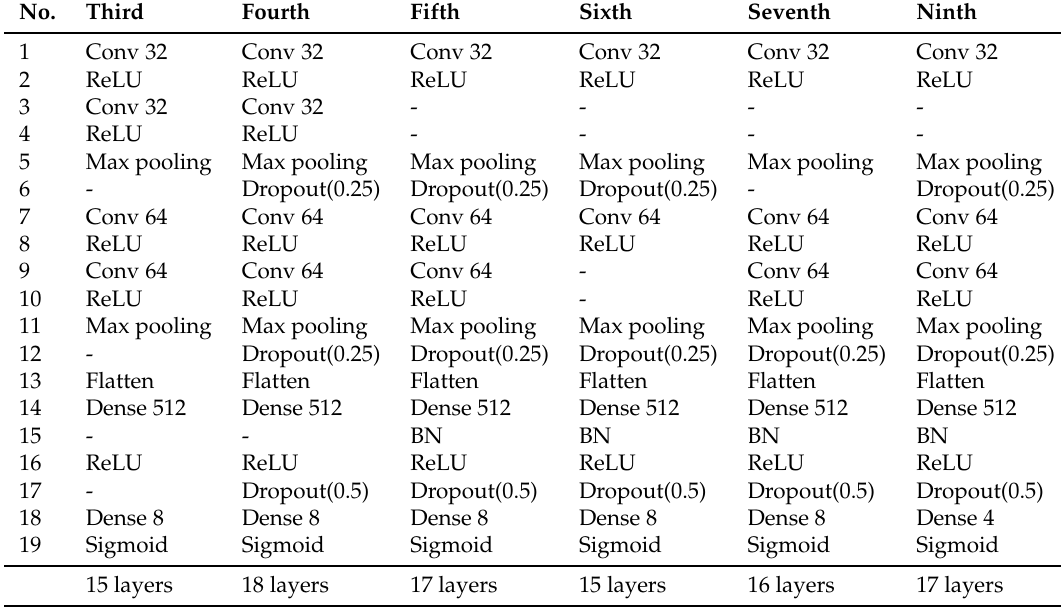
Table 3. Architecture of the third, fourth, fifth, sixth, seventh, and ninth models.